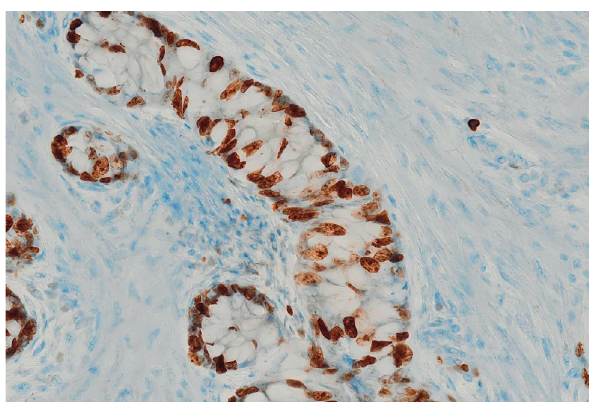
Fig. 6. Immunohistological reaction with the Ki-67 antibody. Significant positivity of most tumor cells (Ki-67,